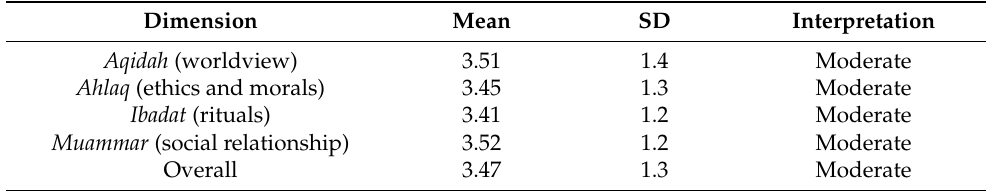
Table 3. Descriptive analysis of